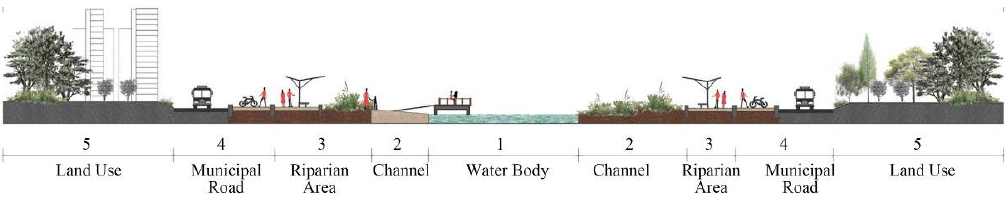
Figure 3. Schematic diagram of the waterfront segment.